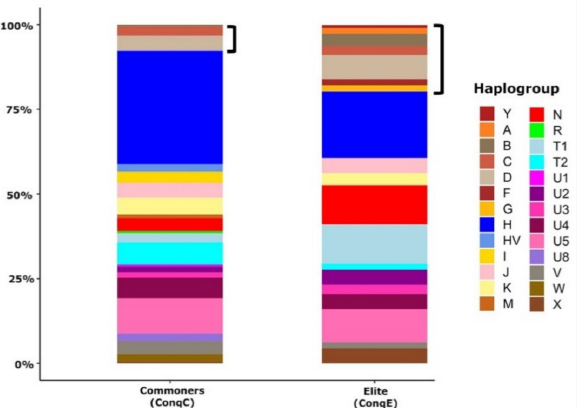
Figure 3. Comparison of the major Hg distributions from ancient Hungarian populations. The major Hg distribution of commoner samples (n = 182) from this study is distinct from that of Conqueror elite samples (n = 112) taken from previous studies [6,12,31], including elite data from Magyarhomorog in the present study. Brackets mark east Eurasian